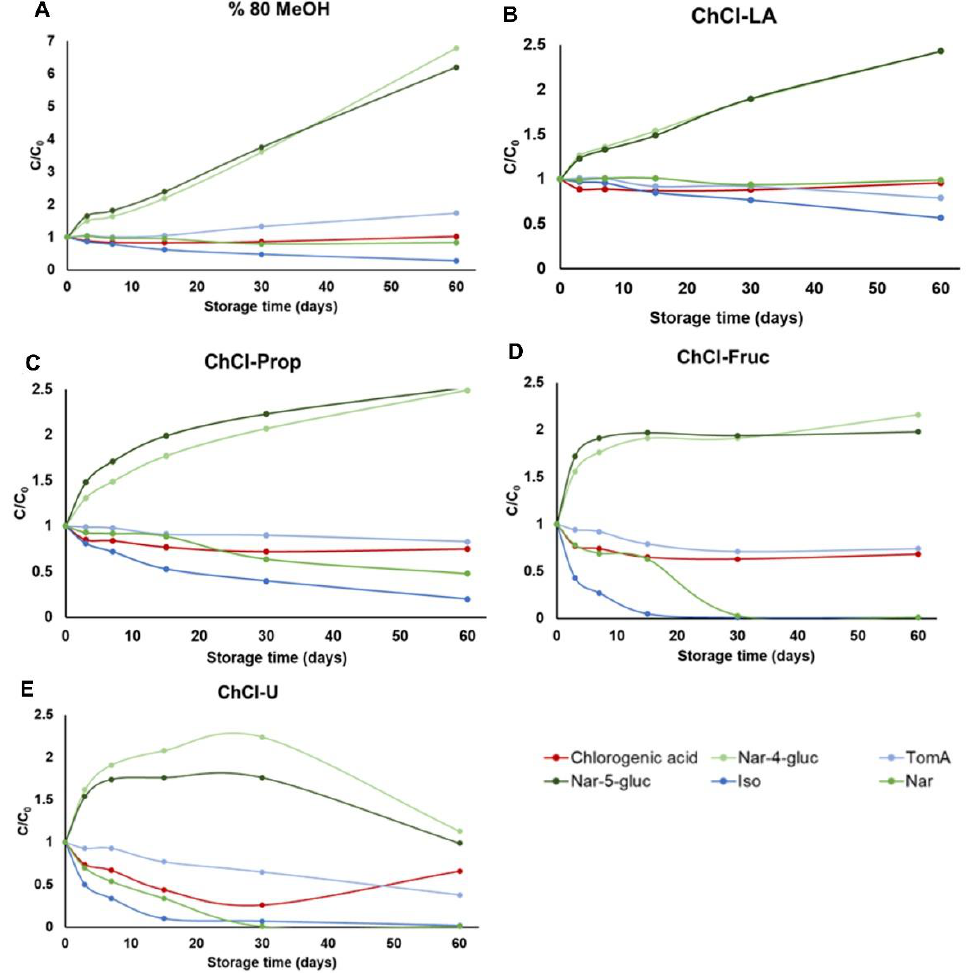
Figure 4. Stability of the selected phenolic compounds extracted from H. arenarium with five different solvents (A) 80% MeOH, (B) choline chloride-lactic acid (1:2) NADES, (C) choline chloride:1,2-propanediol (1:2) NADES, (D) choline chloride:fructose:water (2:1:1) NADES and (E) choline chloride:urea (1:2) NADES), over a period of 0 to 60 days, stored, stored at 4 °C.